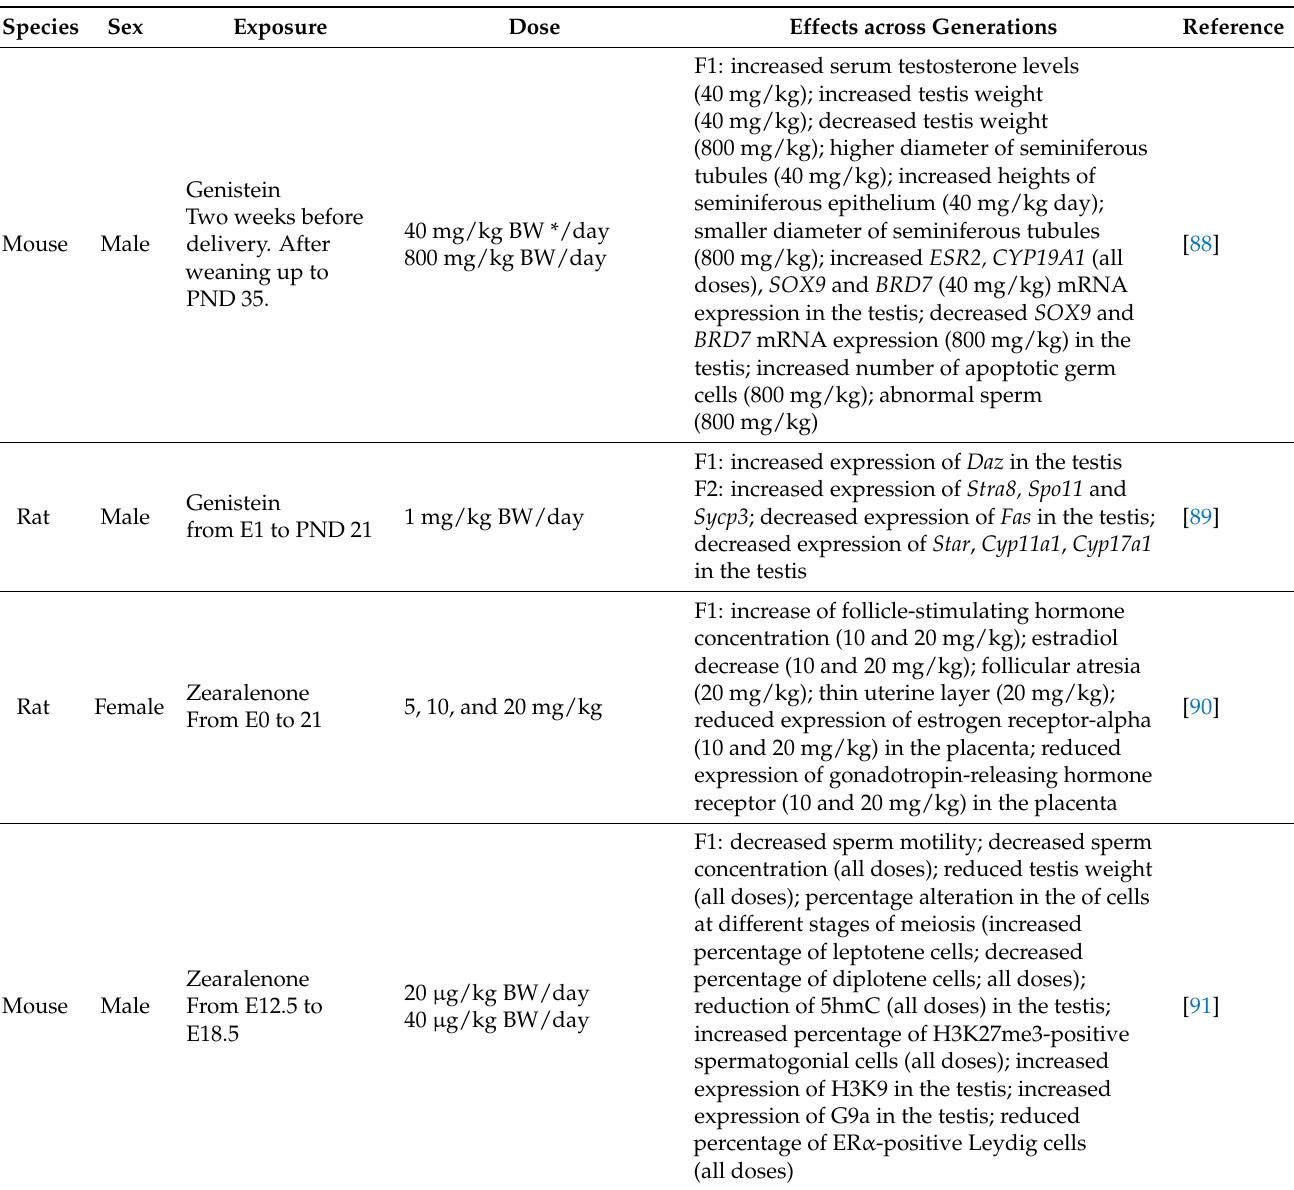
Table 1. Phytoestrogens and Mycotoxins-Induced Effects In Model Animals Across Generations. Effects across